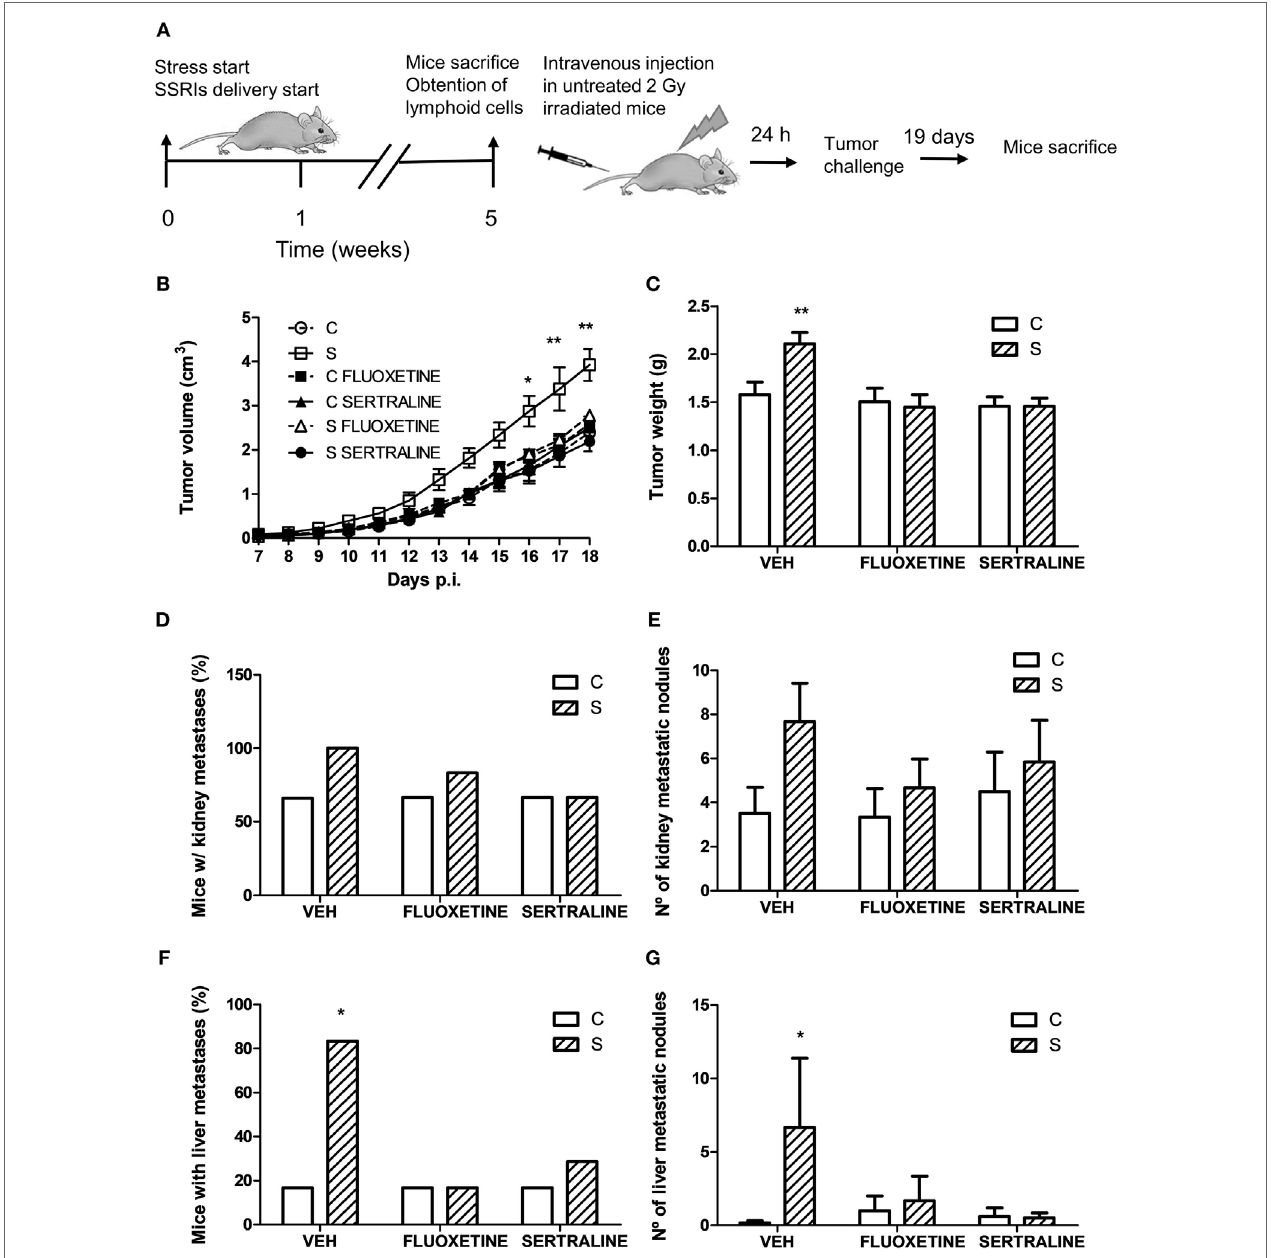
FigUre 9 | Evaluation of antitumor immunity role in tumor biological behavior using adoptive cell transfer strategy. (a) Schematic representation of experimental protocol. Mice were treated either with (S) or without (C) the chronic stress protocol, and with or without (VEH) fluoxetine or sertraline. Five weeks later, mice were sacrificed and lymphoid cells from different experimental groups were tail vein injected in untreated irradiated mice. After 24 h, EL4 cells were subcutaneously injected to generate solid tumors. 19 days post subcutaneous injection, mice were sacrificed, and spontaneous metastasis was evaluated. (B) Time course of tumor volume for the different experimental groups. (c) Tumor weight at day 19 post EL4 cells injection. (D) Percentage of mice with metastatic nodules in kidney or liver (F) was calculated. Also, number of metastatic nodules in kidney (e) or liver (g) was assessed. Values are expressed as mean ± SEM. n = 6 mice per group. * p < 0.05, ** p < 0.01 respect to control